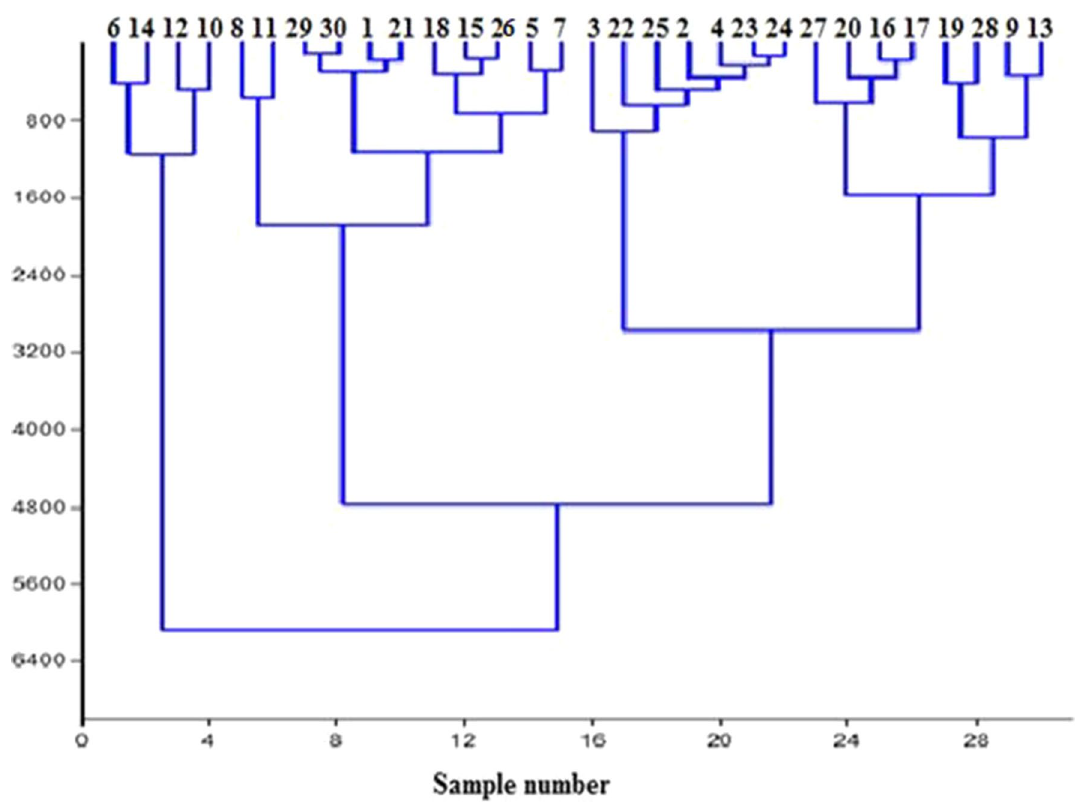
Fig. 5 Dendrogram showing the clustering w.r.t. the springs in Anantnag district, Kashmir